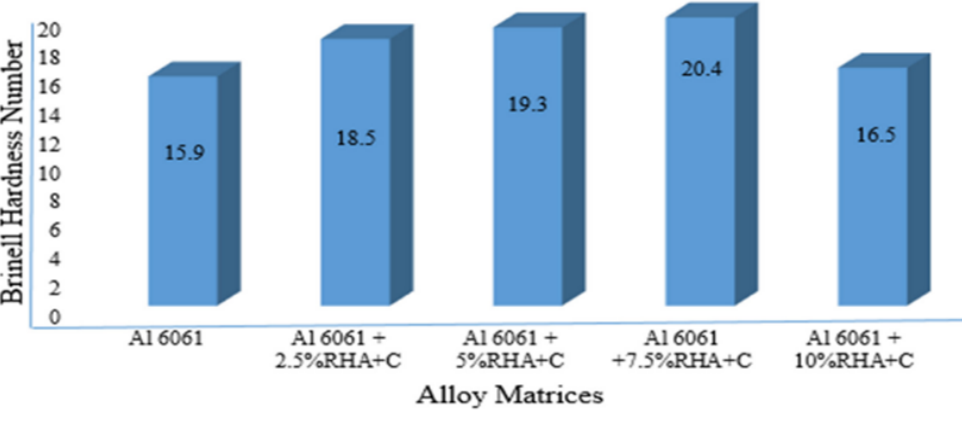
Figure 13. The impact of clay concentration and RHA on microhardness of the alloy matrix. Gupta et al. [116] examine the wear behaviour and dry sliding friction of AA7075 composites reinforced with carbonized eggshells and rice husk ash. The stir casting method was used to create composites with varied weight percentages of carbonized egg- shells and rice husk ash in the range of 0 to 5 wt.%. Prior to tribological testing, density, porosity content, and microhardness were computed. On a pin-on-disc type tribometer operating at room temperature, tests for friction and wear were performed. The samples